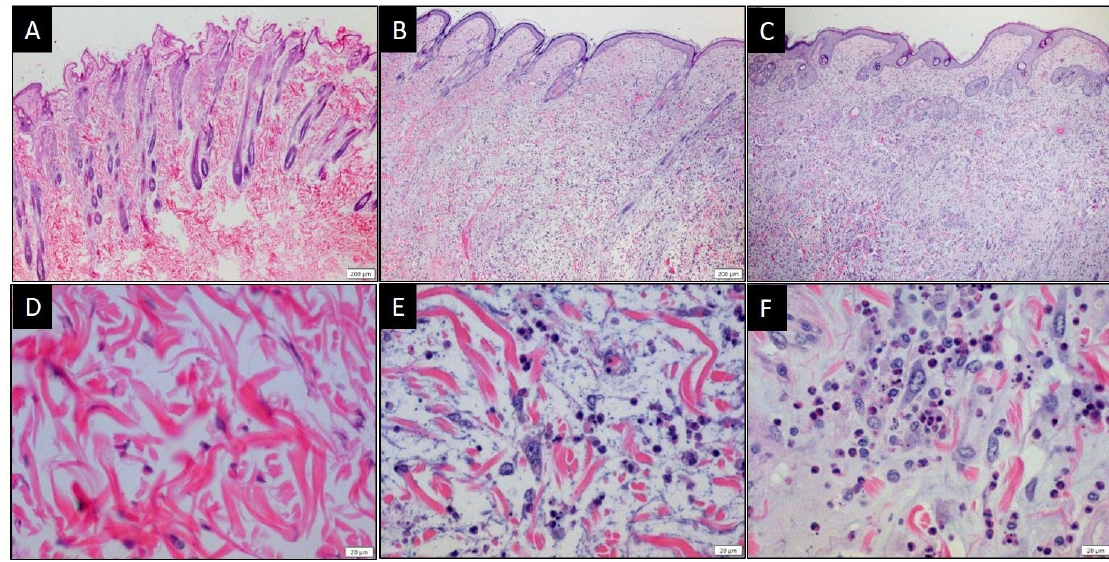
Figure 12. Photomicrographs of skin from the lateral thigh of rabbits injected with ( A , D ) saline [28], ( B , E ) 50 pfu MYXV, or ( C , F ) 50 pfu MYXVorfC. Samples were collected at the time of euthanasia, processed, and stained with H&E (A, B, and C magnification 10 × objective; D, E, and F magnification 40 × objective).